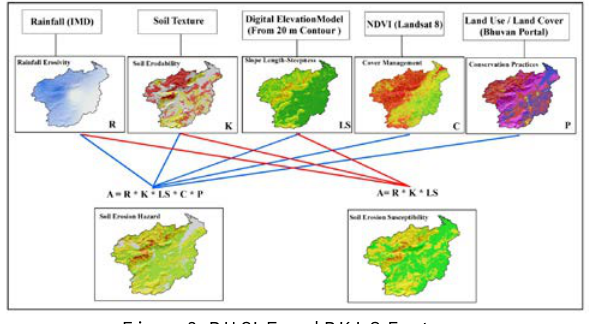
Figure 3. RUSLE and RKLS